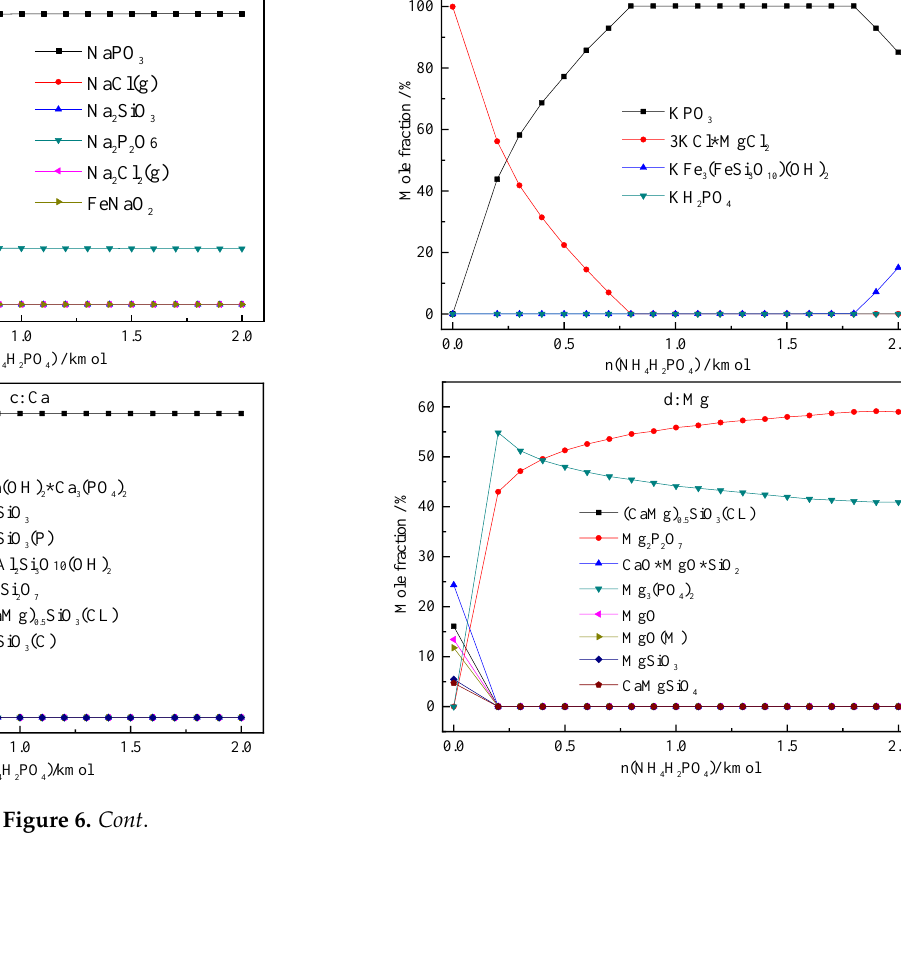
Figure 6. Effect of the amount of NH 4 HPO 4 addition on the migration and transformation of main elements in ash. ( a ): Na, ( b ): K, ( c ): Ca, ( d ): Mg, ( e ): Cl, ( f ): Si. The asterisk in the chemical formula shows that the molecules or species are attached with each other as independent species, similarly hereinafter. 3.1.7. Effect of Cu(NO 3 ) 2 Addition on the Migration and Transformation of Major Ele- ments in Ash by Using Thermodynamic Equilibrium Analysis The effect of the amount of Cu(NO 3 ) 2 addition on the migration and transformation of sodium, potassium, calcium, magnesium, chloride, and silicon is depicted in Figure 7a – f, respectively. The addition of Cu(NO 3 ) 2 shows the same effect as that of Ba(NO 3 ) 2 . The migration and transformation of sodium, potassium, and chlorine do not change signifi- cantly after the addition of Cu(NO 3 ) 2 . The main forms of sodium, potassium, and chlorine are gaseous NaCl and 3KCl·MgCl 2 . The addition of Cu(NO 3 ) 2 alters the main forms of cal- cium and magnesium. As shown in Figure 7c,d, the addition of Cu(NO 3 ) 2 favors the for- mation of MgO and CaO, which could be attributed to the competitive reactions of copper,